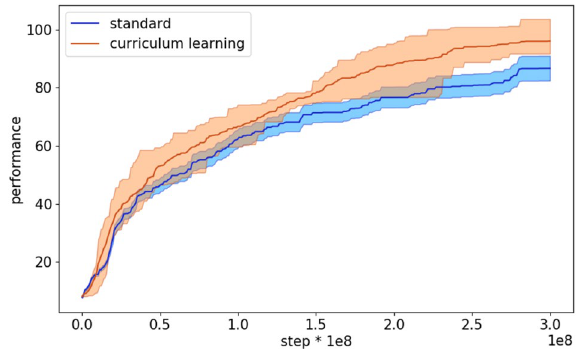
Figure 13. Performance during the evolutionary process of the agents evolved with the standard and with curriculum learning Steady State algorithms on the bipedal hardcore problem. The latter data refers to the experiments performed with the cubic difficulty function. Each curve shows the average results of 10 replications. The shadow indicate the 90% bootstrapped confidence